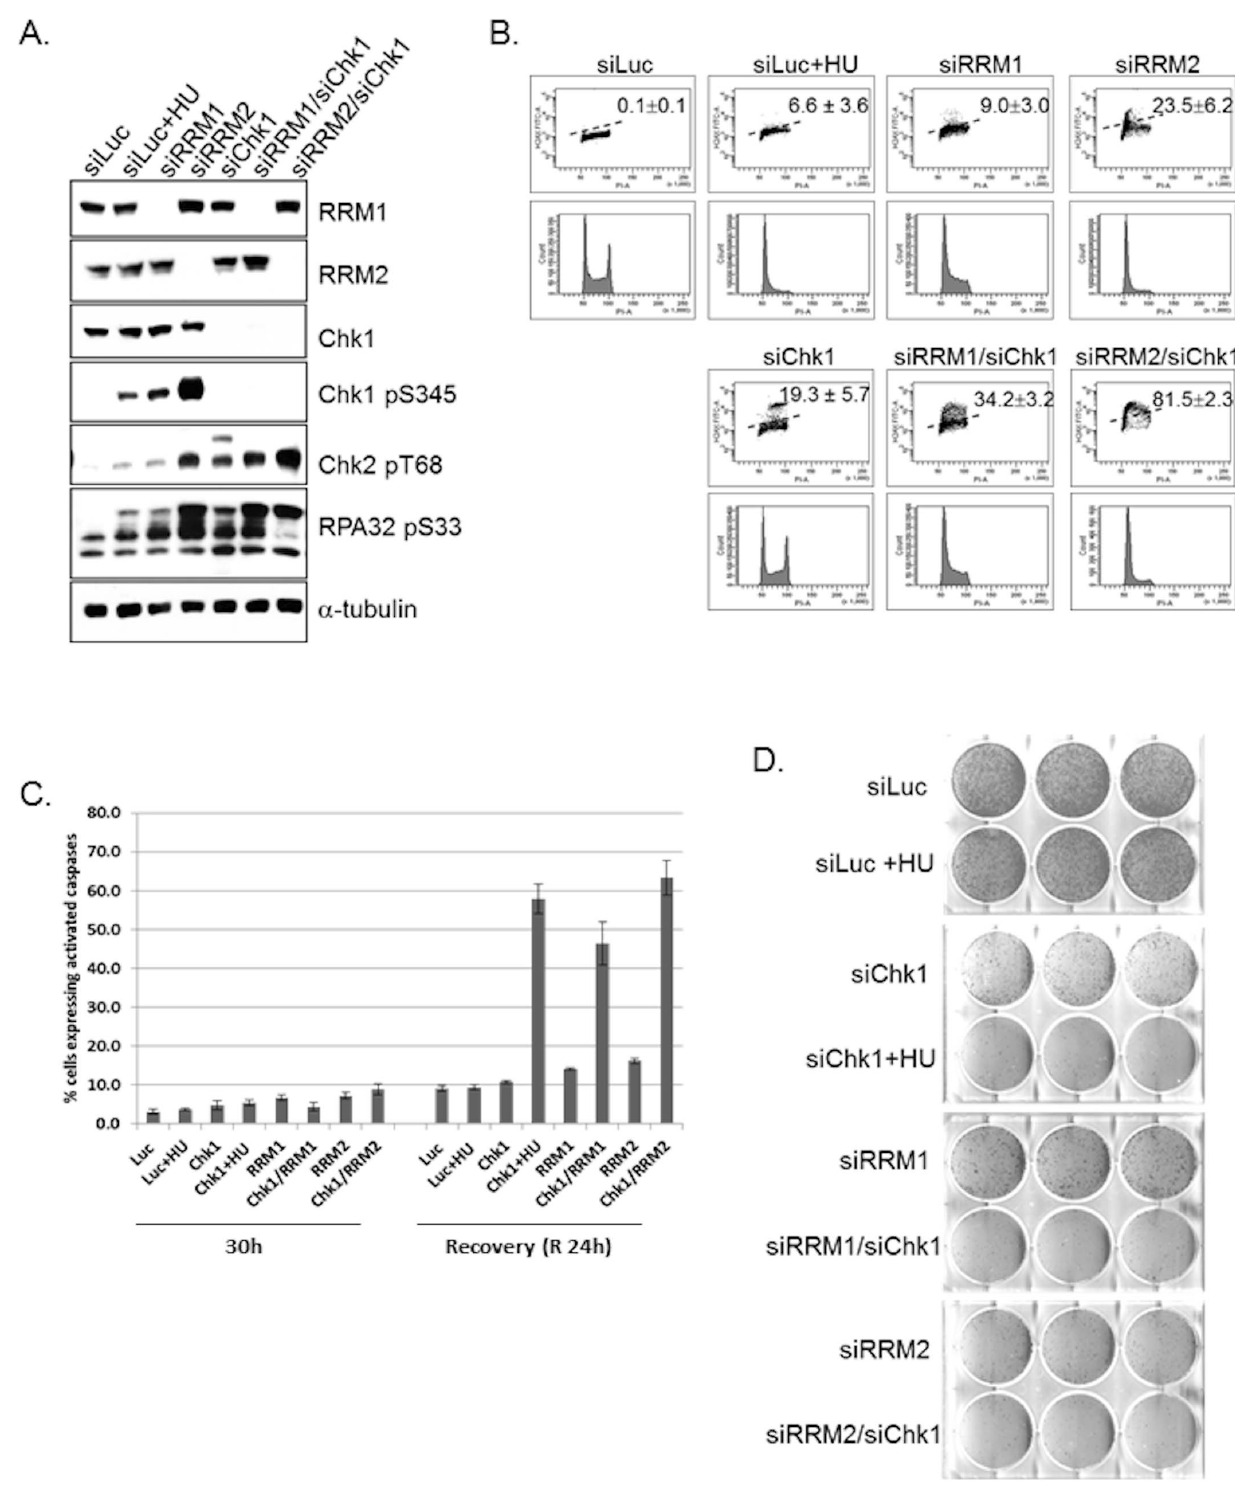
Figure 3. RRM1/Chk1 and RRM2/Chk1 co-depletion enhances the accumulation of DNA damage, apoptotic response and effects cell proliferation in U2OS cells. Cells were transfected with Chk1, RRM1, RRM2, RRM1/Chk1, RRM2/Chk1, and Luciferase control (untreated or treated with 1 mM HU for the last 8 h) before harvesting at 30 h. At 30 h after siRNA transfections, (a) extracts were prepared and immunoblotted with the indicated antibodies. (b) DNA damage was assessed for c -H2AX phosphorylation using flow cytometry. (c) Cells were collected at indicated time points indicated and analyzed for activated caspases. Data performed in duplicates. Error bars represent SD between experiments. (d) Cell proliferation was assessed with clonogenicity assay.